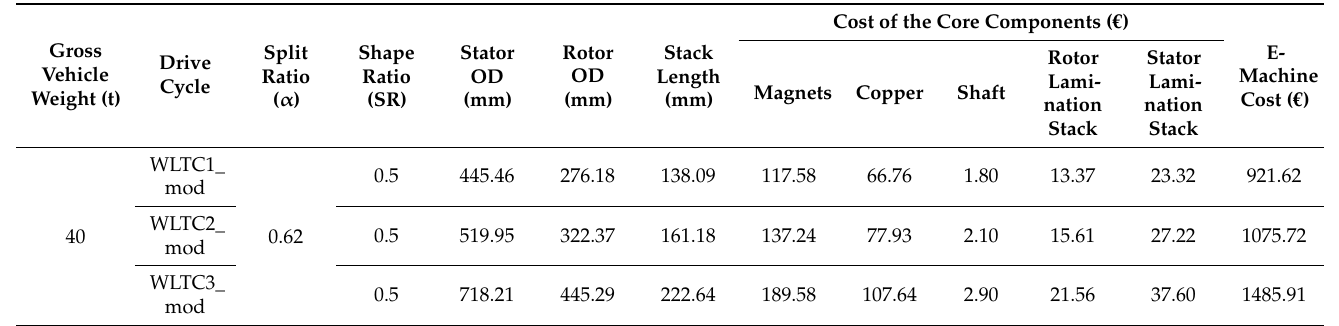
Table 11. Overview of the most cost-effective e-machines for different use cases in the 40 t vehicle category.